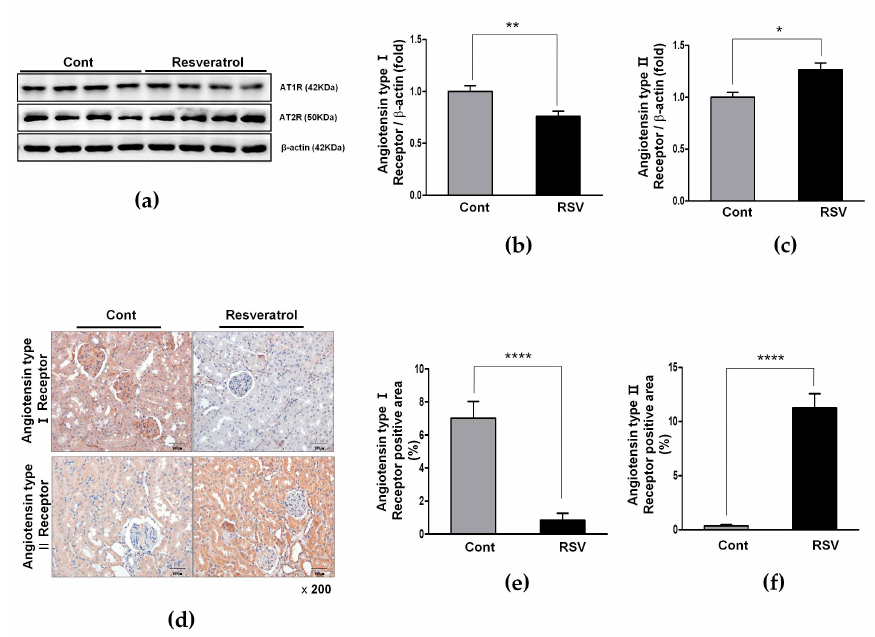
Figure 6. Effects of resveratrol on the AT1R and AT2R. ( a ) Representative western blots of AT1R and AT2R. ( b ) The expression of AT1R was significantly decreased in the RSV group. ( c ) The expression of AT2R was significantly increased in the RSV group. ( d ) Representative images of immunohistochemistry for AT1R and AT2R, in the aging kidney glomerulus (original magnification × 200). ( e ) The expression of AT1R-positive area in the kidney was markedly decreased in the RSV group. ( f ) The expression of AT2R-positive area in the kidney was markedly increased in the RSV group (* p < 0.05, ** p < 0.01, **** p < 0.0001).